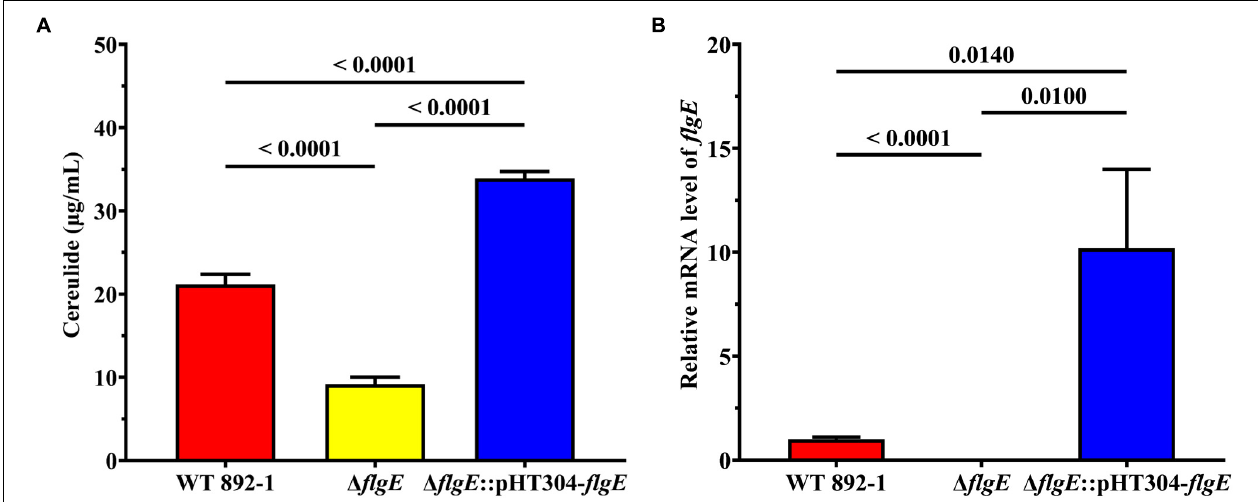
FIGURE 6 | Deletion of flgE significantly decreased cereulide production. (A) Cereulide production by wild-type strain, (cid:49) flgE and (cid:49) flgE :pHT304- flgE . (B) Relative mRNA levels of flgE in wild-type strain, (cid:49) flgE , and (cid:49) flgE :pHT304- flgE . P values were calculated using the Student’s t -test. Error bars represent the standard deviation of the